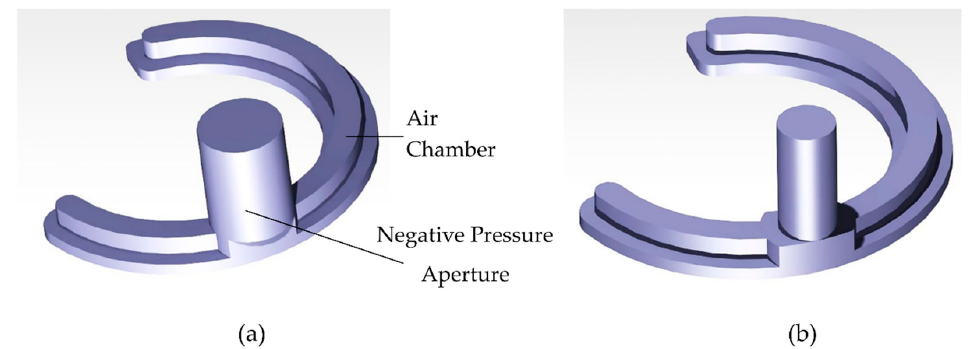
Figure 6. Connection area of negative pressure aperture and air chamber. ( a ) Diameter of negative pressure aperture is 34 mm; ( b ) diameter of negative pressure aperture is 21.5 mm.